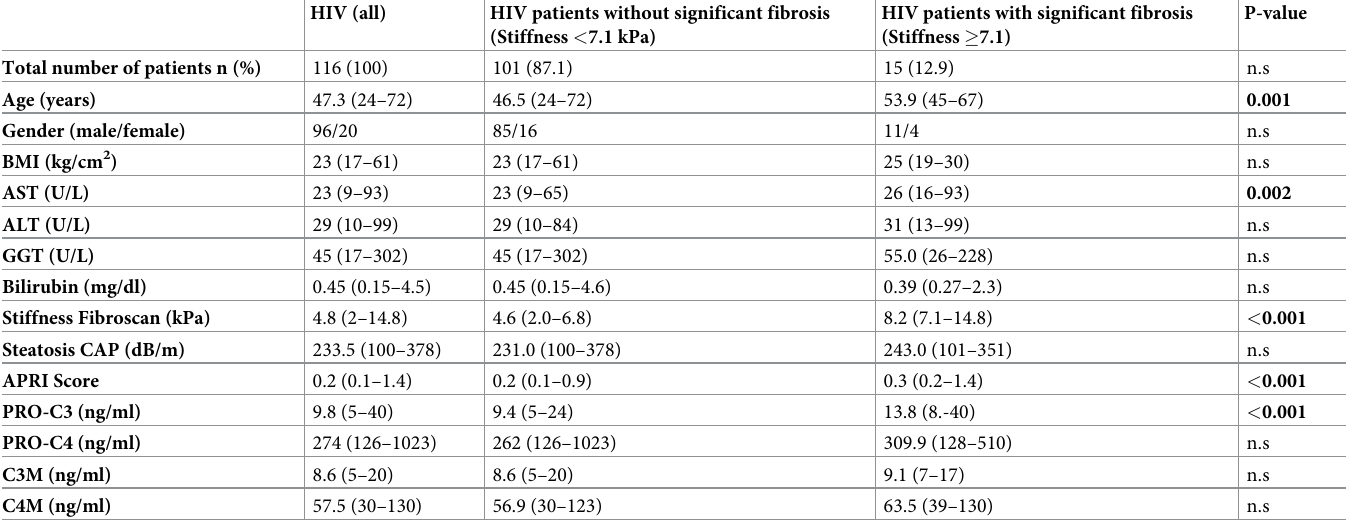
Table 1. Clinical parameters of patients stratified by stiffness. All values are given as median and range. BMI: Body-mass index, AST: aspartate aminotransferase, ALT: alanine aminotransferase; GGT: γ –glutamyl transferase, CAP: Controlled attenuation parameter. HIV (all) HIV patients without significant fibrosis HIV patients with significant fibrosis (Stiffness < 7.1 kPa) (Stiffness � 7.1)